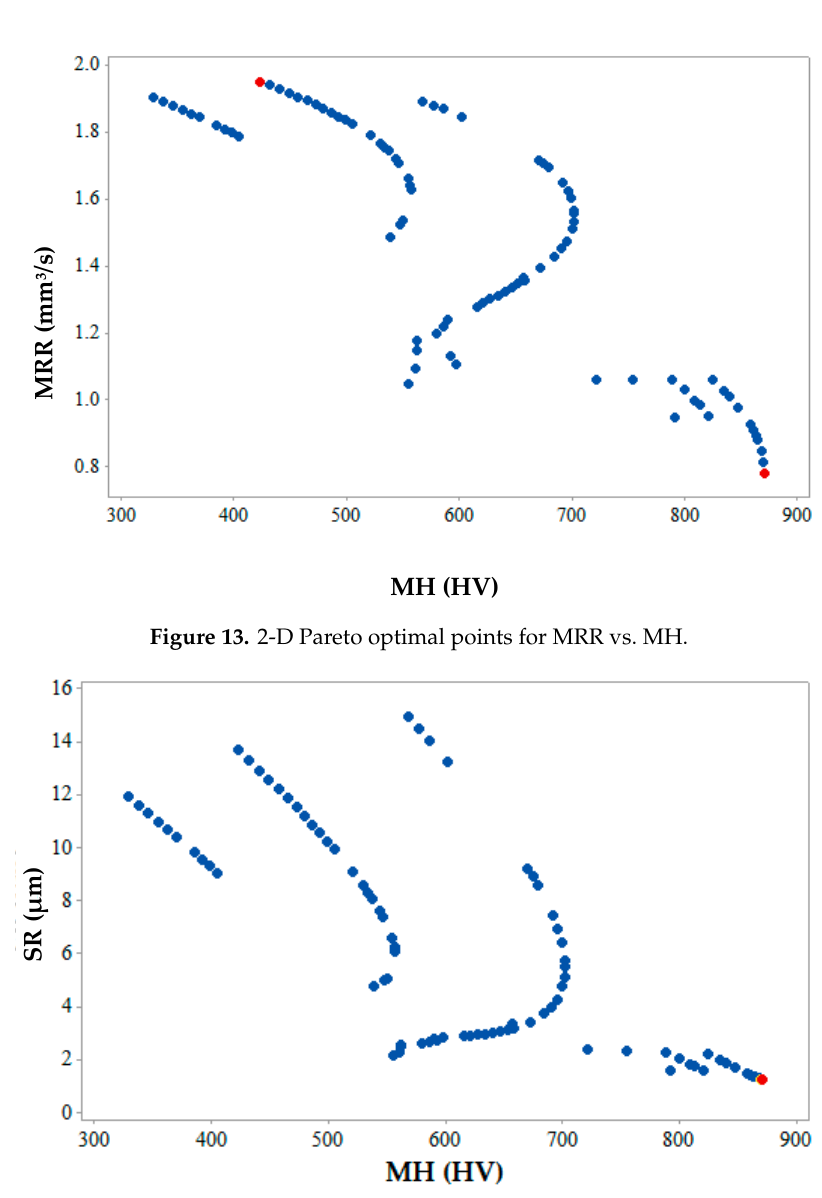
Figure 14. 2-D Pareto optimal points for SR vs. MH.